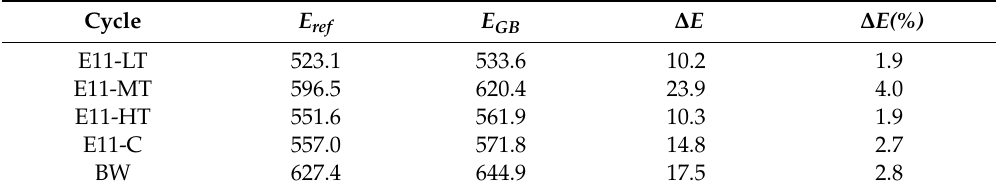
Table 5. Energy consumption comparison between the CVT and the reference powertrains. Positive ∆ E value represents consumption disadvantage with